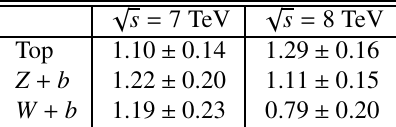
Table 4. Rescaling factors obtained from the fit to the data for the V + b and top backgrounds [9]. The error includes statistical and systematic uncertainties.